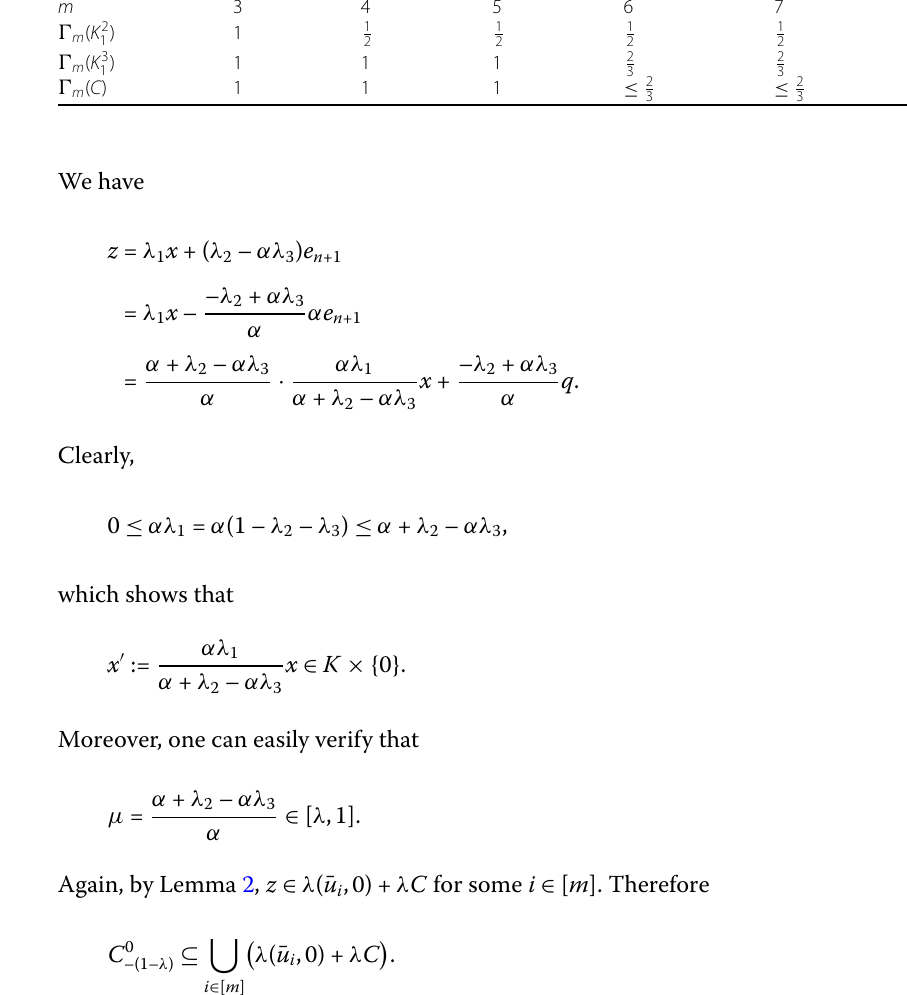
) (cf. [11, p. 333] ) and (cid:3) m ( K 3 1